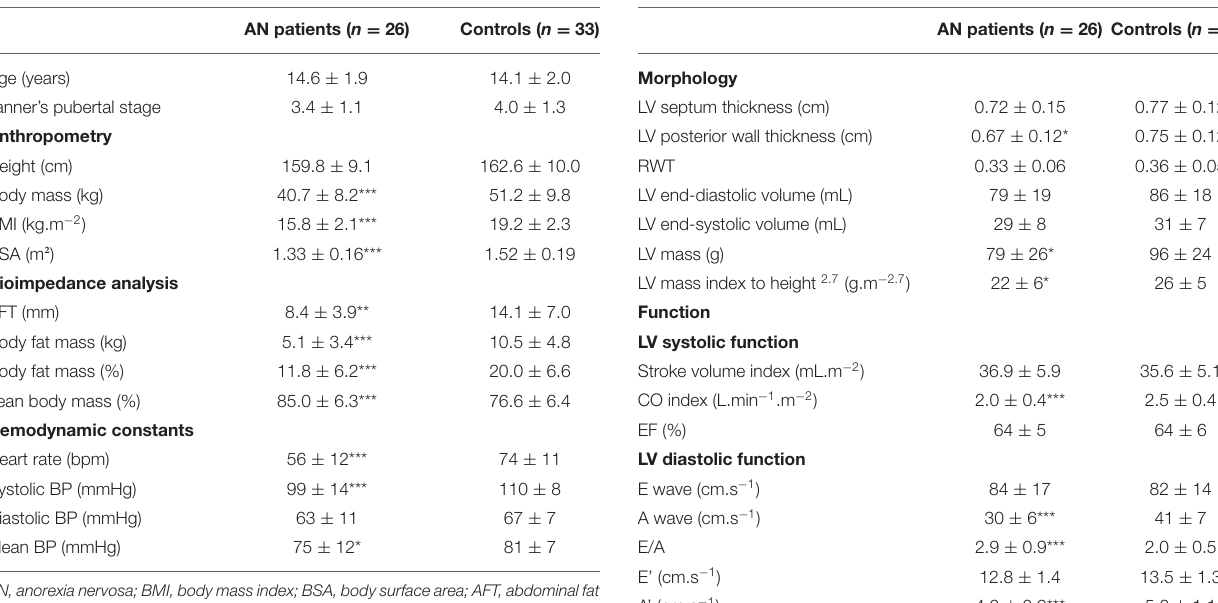
TABLE 1 | Baseline characteristics of AN patients and controls. TABLE 2 | Left ventricular morphology and function in AN patients and controls.